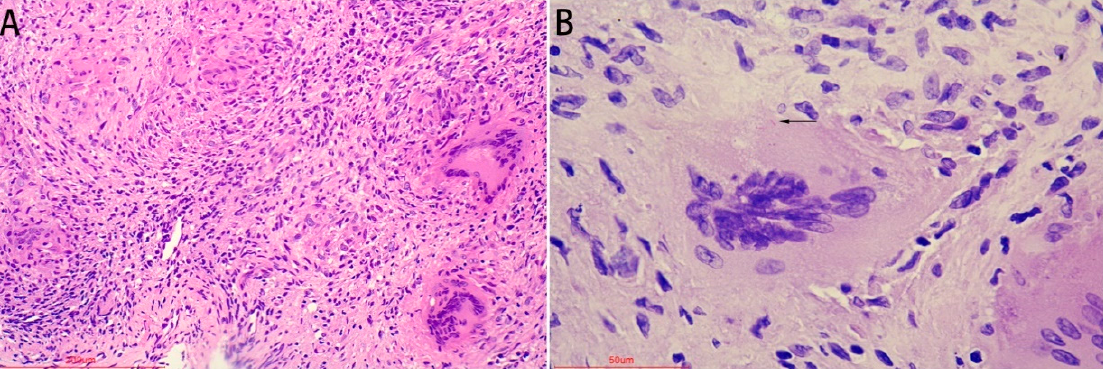
Figure 3. Histological features represented by lung tissue. H&E staining ( A ), tuberculous granulomas with caseous necrosis; Acid-fast staining ( B ), the black arrow showed the positive bacteria.